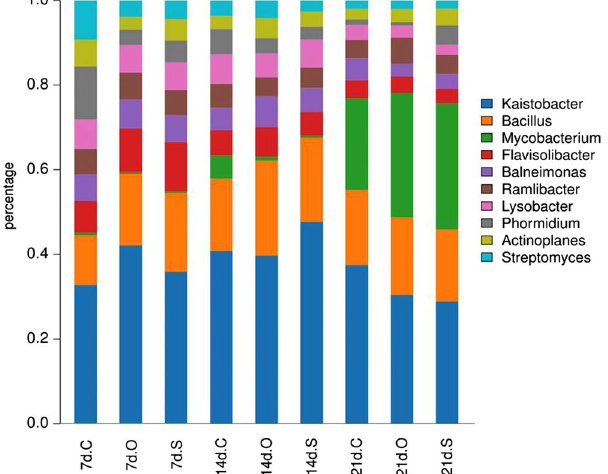
Figure 4. Biodiversity of 10 dominant bacterial genera expressed as relative abundance (%) of OTUs in soil.